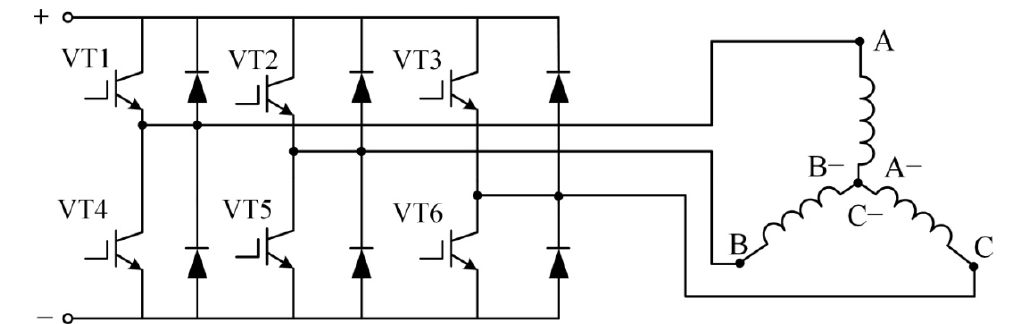
Figure 18. Drive